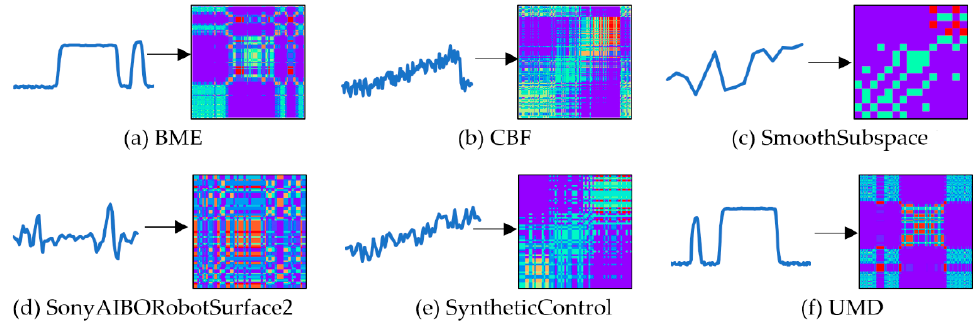
Figure 4. The effect of converting the time-series into MTF